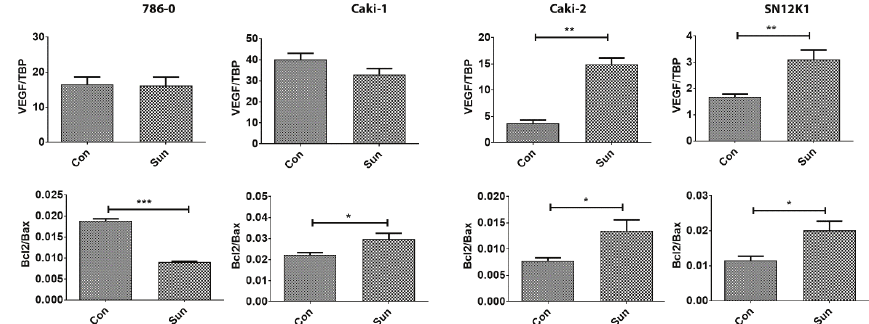
Figure 7. Differential expression of proangiogenic and apoptosis-regulatory genes in resistant cells. There was an increased expression of the proangiogenic gene VEGF in Caki-2 and SN12K1 cells and an increased Bcl2/Bax ratio in Caki-1, Caki-2 and SN12K1 cells. *P < 0.05, **P < 0.01 and ***P <